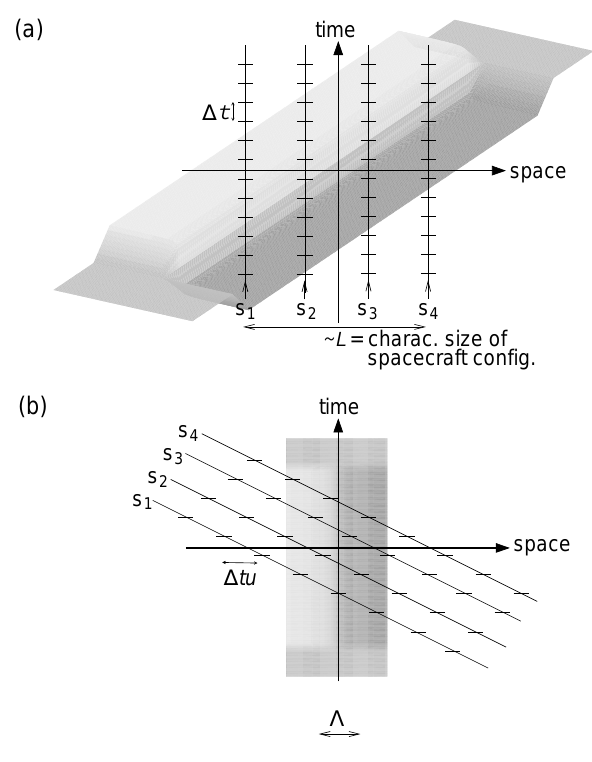
Fig. 1. (a) A current sheet passing four satellites, s 1 – s 4 , in the frame of reference moving with the satellites. (b) The current sheet and the spacecraft in the reference frame moving with the sheet.